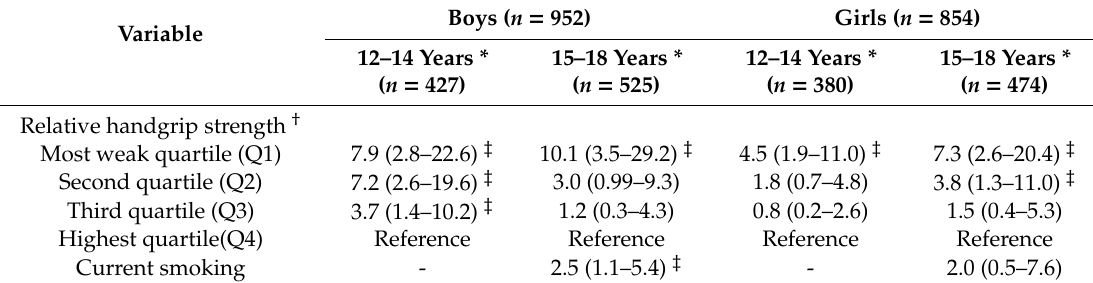
Table 3. Odds ratios for the association of relative handgrip strength and smoking behavior with high cardiometabolic risk according to age